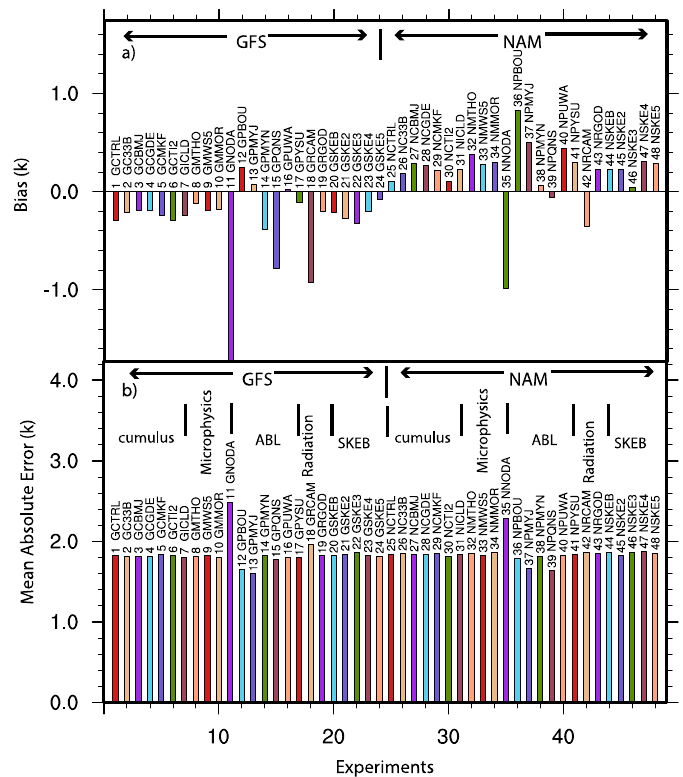
Figure 12. Averages on Domain 3 of ( a ) bias and ( b ) MAE in T2 from forecasts during the one-week study period in July.